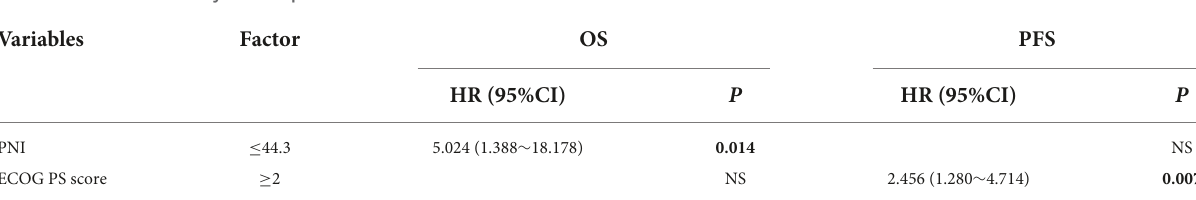
TABLE 4 Multivariate analysis of FL patients.